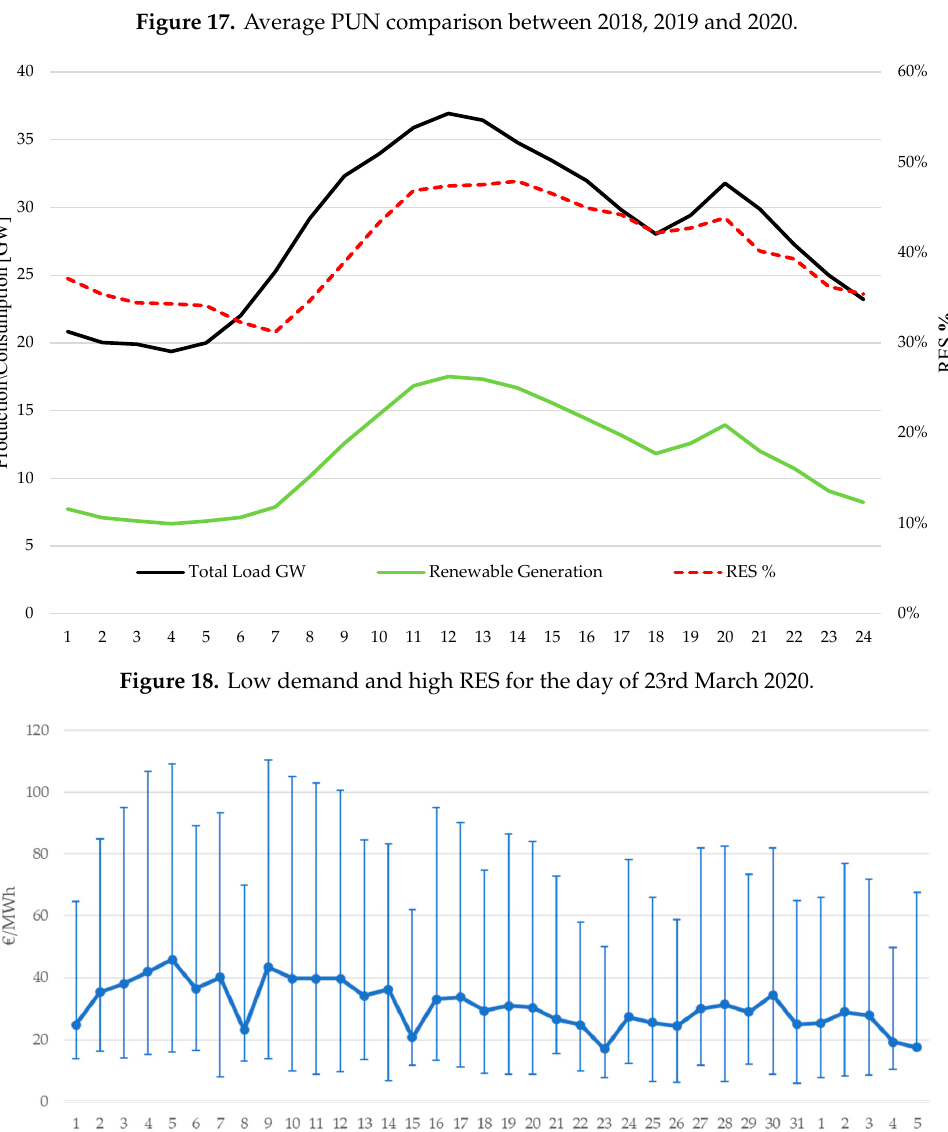
Figure 17. Average PUN comparison between 2018, 2019 and 2020.